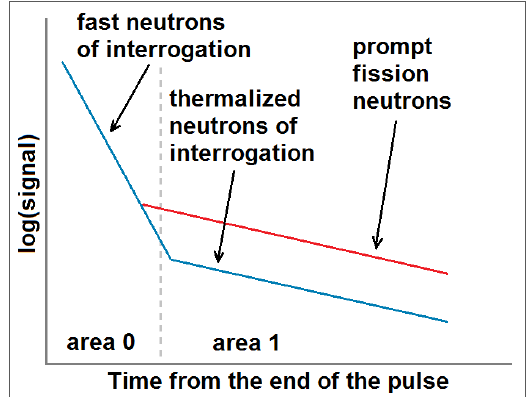
Figure 1. Theoretical Differential Die-Away Time Analysis (DDAA) signals against time in the presence of fissile material (red line) or other materials (blue line). The region of interest for detecting fissile material is labeled “area 1” where differences between the curves can be observed.